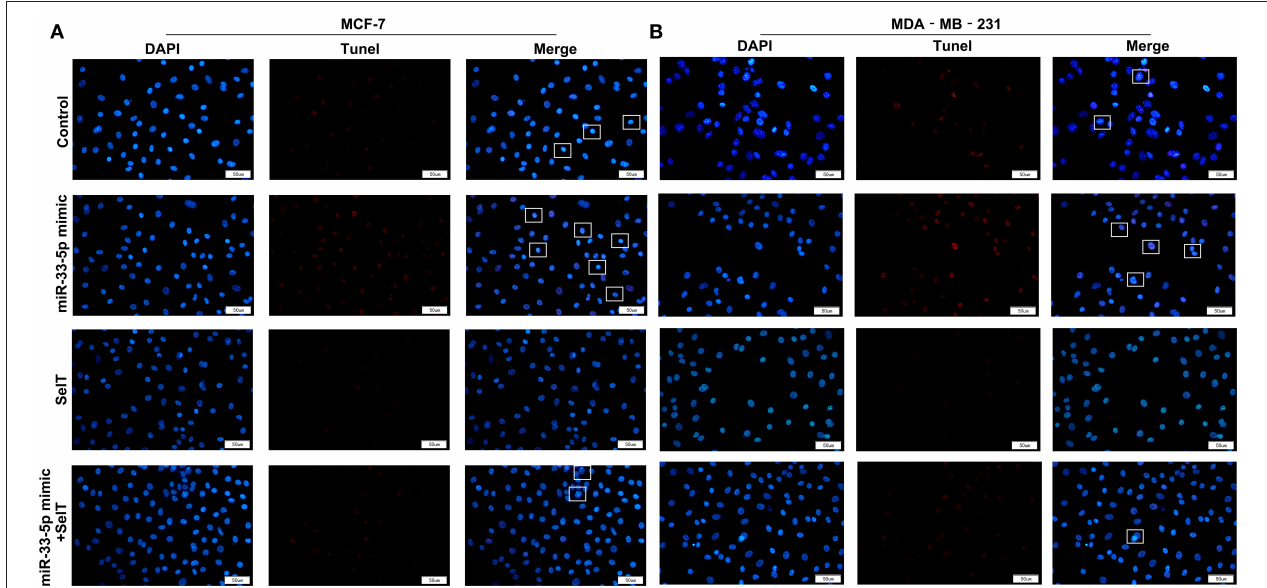
FIGURE 6 | TUNEL staining for (A) MCF-7 as well as (B) MDA-MB-231 cell apoptosis transfected by hsa-miR-33-5p mimics and/or SelT. Bar = 50 µ m. Magnification, × 400.